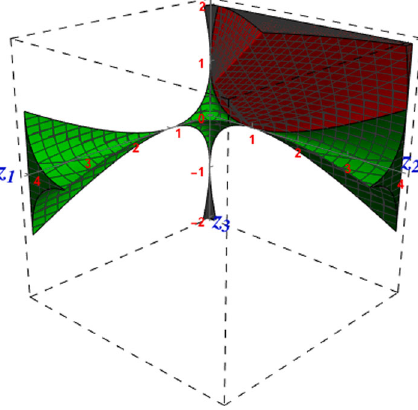
Fig. 7 Intersection of the convergence regions of Eqs. (35), (36) and (37) for real z i , in red